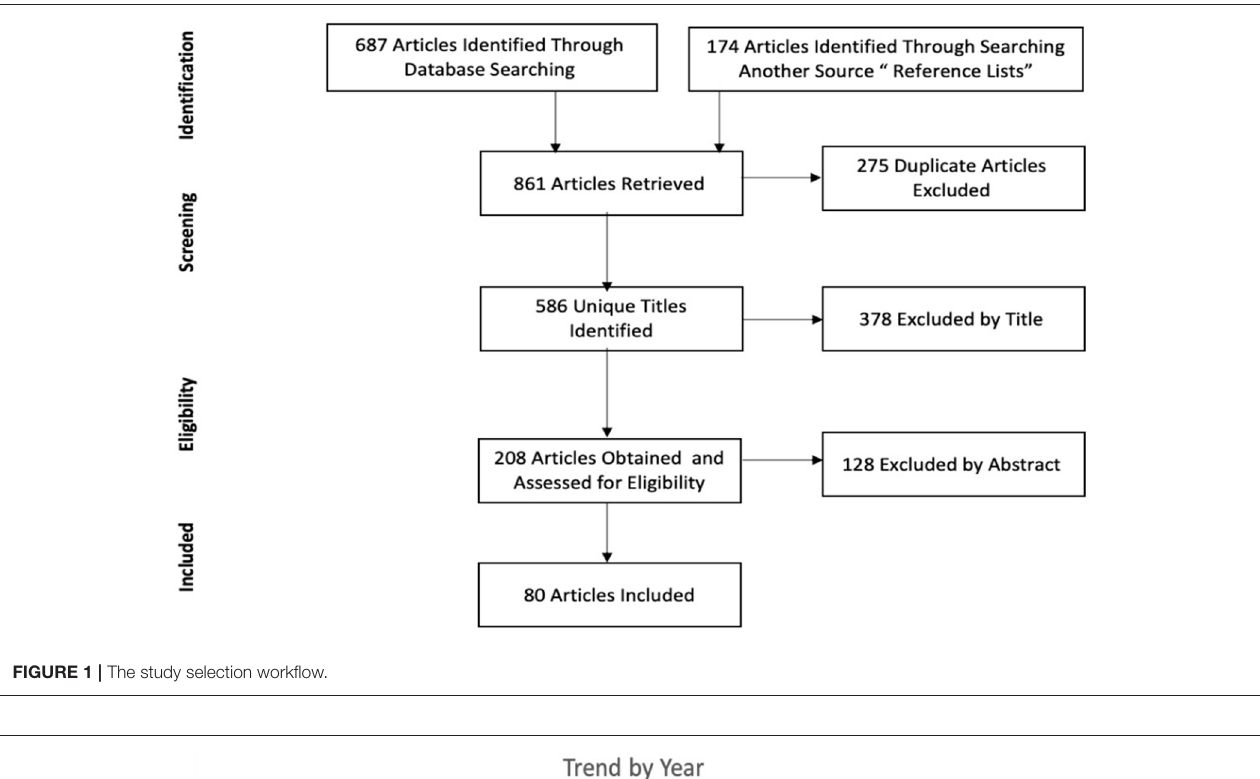
FIGURE 1 | The study selection workflow.